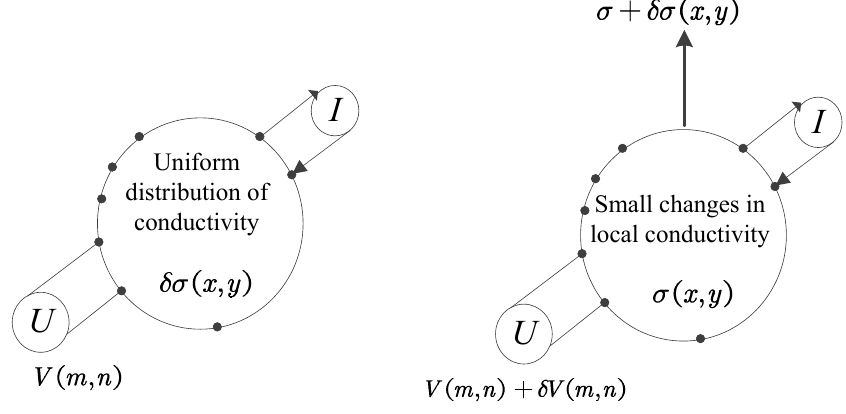
Figure 4. Four-electrode current excitation voltage measurement method.